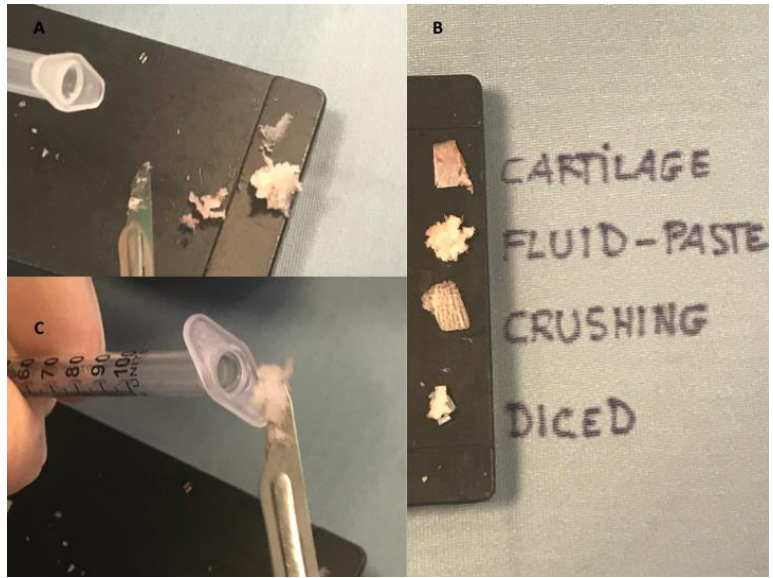
Figure 2. All cartilage products obtained. ( A ) – ( B ) Fluid, diced, and crushing cartilage products obtained by septal cartilage in comparison. ( C ) The insertion of cartilage paste obtained in a 1-ml Luer lock syringe.